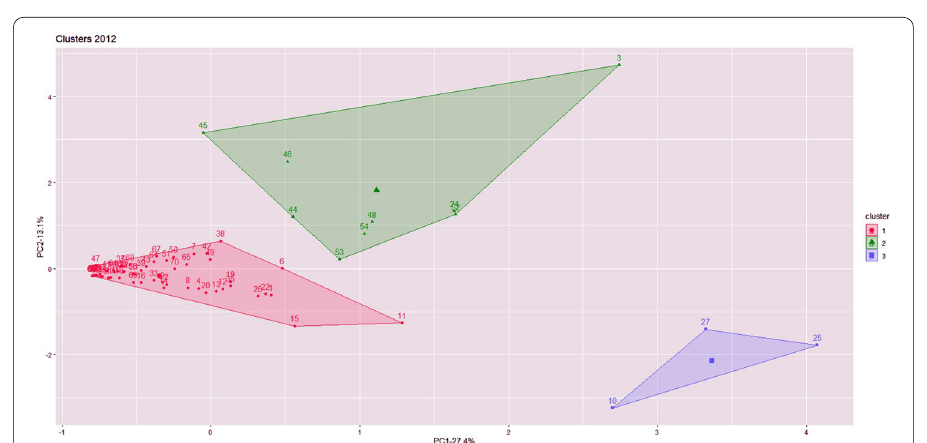
Fig. 6 Clusters of industries,